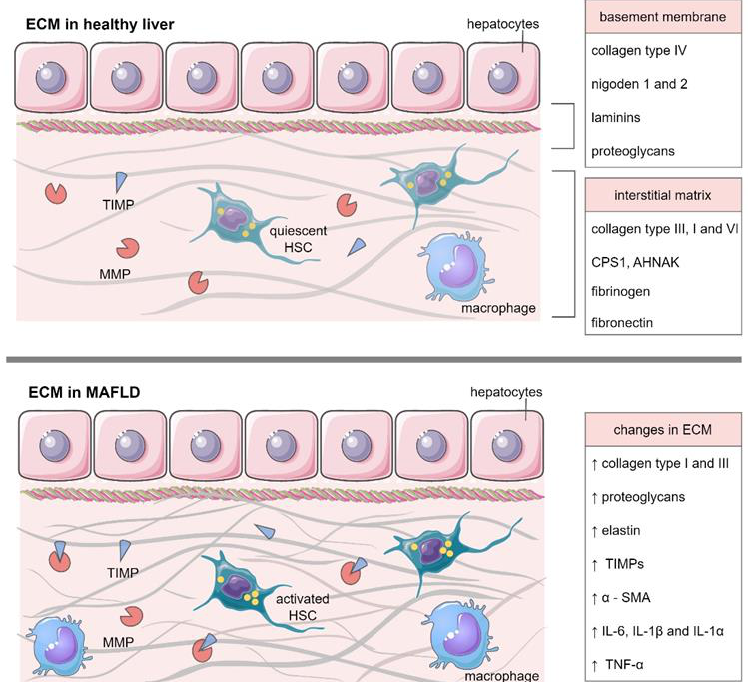
Figure 1. Extracellular matrix composition in healthy liver and MAFLD. α -SMA—smooth muscle alpha-actin, AHNAK—neuroblast differentiation-associated protein, CPS1—carbamoyl-phosphate synthase 1, HSC—hepatic stellate cell, IL—interleukin, MMP—matrix metalloproteinase, TIMP—tissue inhibitors of metalloproteinases, TNF- α —tumor necrosis factor α . The figure was created with aid of the Servier Medical Art.